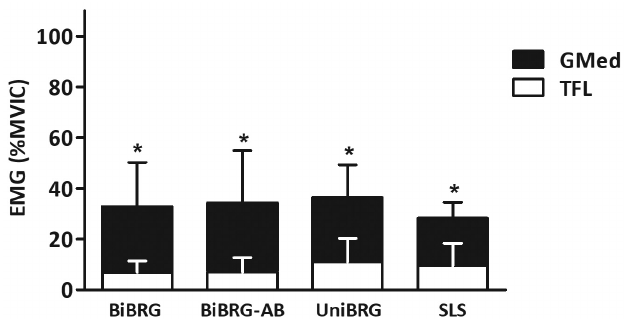
Figure 4. Muscle activation responses (mean±SD) during four multi- joint strengthening exercises. * different between GMed and